Question: Draft a figure caption describing what is shown.
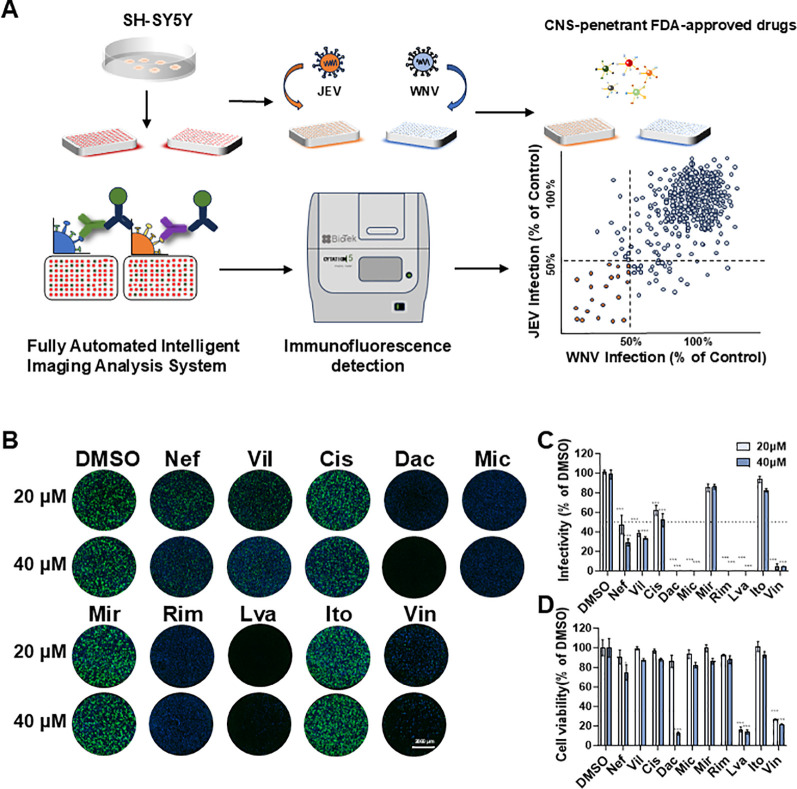
Answer: Screening of anti-WNV candidates from a BBB-penetrant FDA-approved drug library. (A) Schematic of high-throughput screening against WNV and JEV. (B, C) SH-SY5Y cells infected with WNV (MOI = 0.3) in the presence of 10 candidate compounds (20 and 40 μM) for 4 hours. (B) Representative immunofluorescence images (virus antigen, green; DAPI, blue). (C) Quantification of infected cells normalized to DMSO control. (D) Cell viability assessed by CCK-8 assay. Abbreviations: Mic, miconazole nitrate; Nef, neflamapimod; Vil, vilazodone hydrochloride; Dac, dacomitinib; Cis, cisatracurium besylate; Mir, mirtazapine; Rim, rimonabant; Lva, lvacaftor; Ito, itopride hydrochloride; Vin, vinorelbine ditartrate. Data represent the mean ± SD of three biologically independent experiments (n = 3). *P < 0.05, ***P < 0.001 vs. DMSO control.